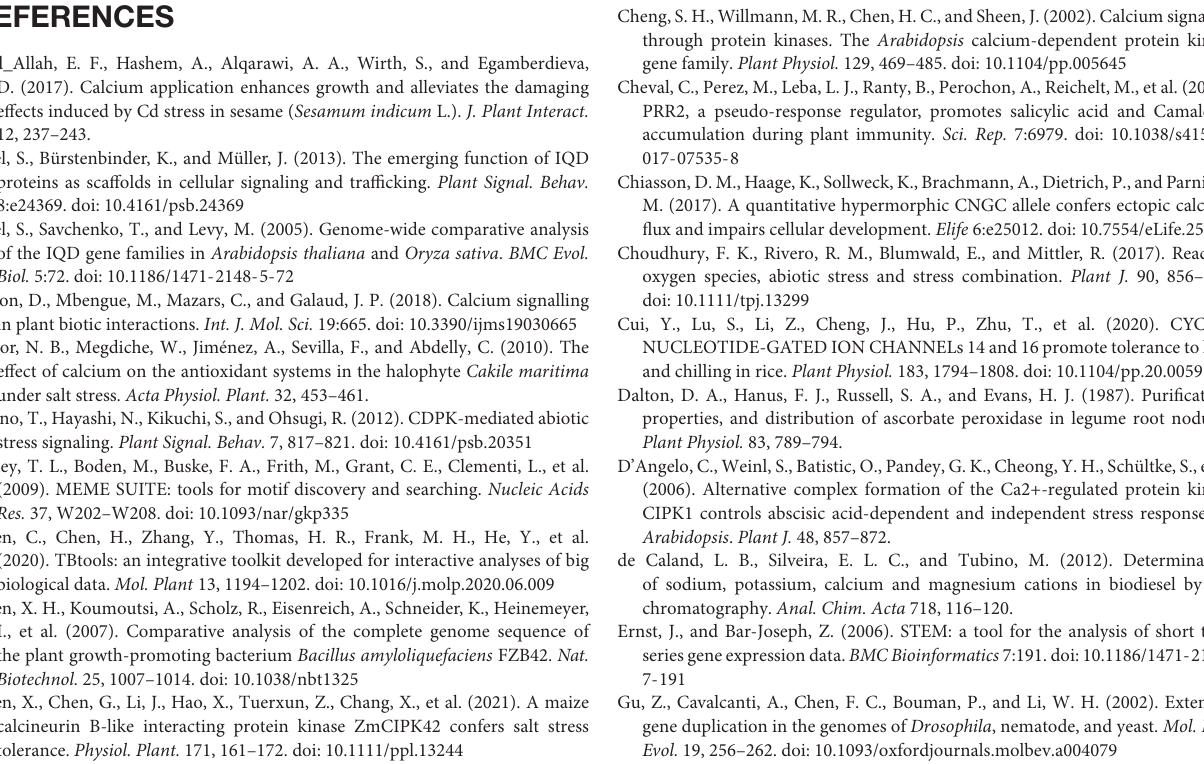
Supplementary Table 6 | The summary of the duplications of the 102 genes in calcium-related gene families detected in A. thaliana . Supplementary Table 7 | The gene pairs and the corresponding position of the 102 genes in calcium-related gene families in A. thaliana. Supplementary Table 8 | The detailed information of pathways enriched in the 102 genes in calcium-related gene families. Supplementary Table 9 | The results of ANOVA based on the expression profiles of all genes in A. thaliana root. Supplementary Table 10 | The detailed information of pathways enriched in DEGs associated with calcium. Supplementary Table 11 | The detailed information of cluster analysis based on the expression profiles of 102 genes in calcium-related gene